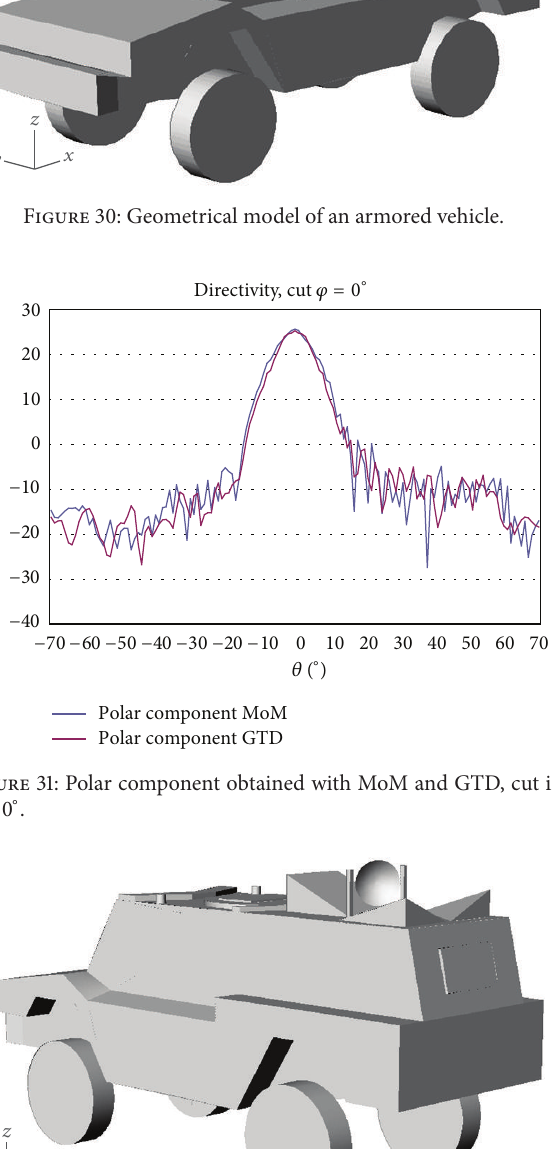
𝑥𝑦𝑧 Figure 32: Geometrical model of the reinforced car with its reflector